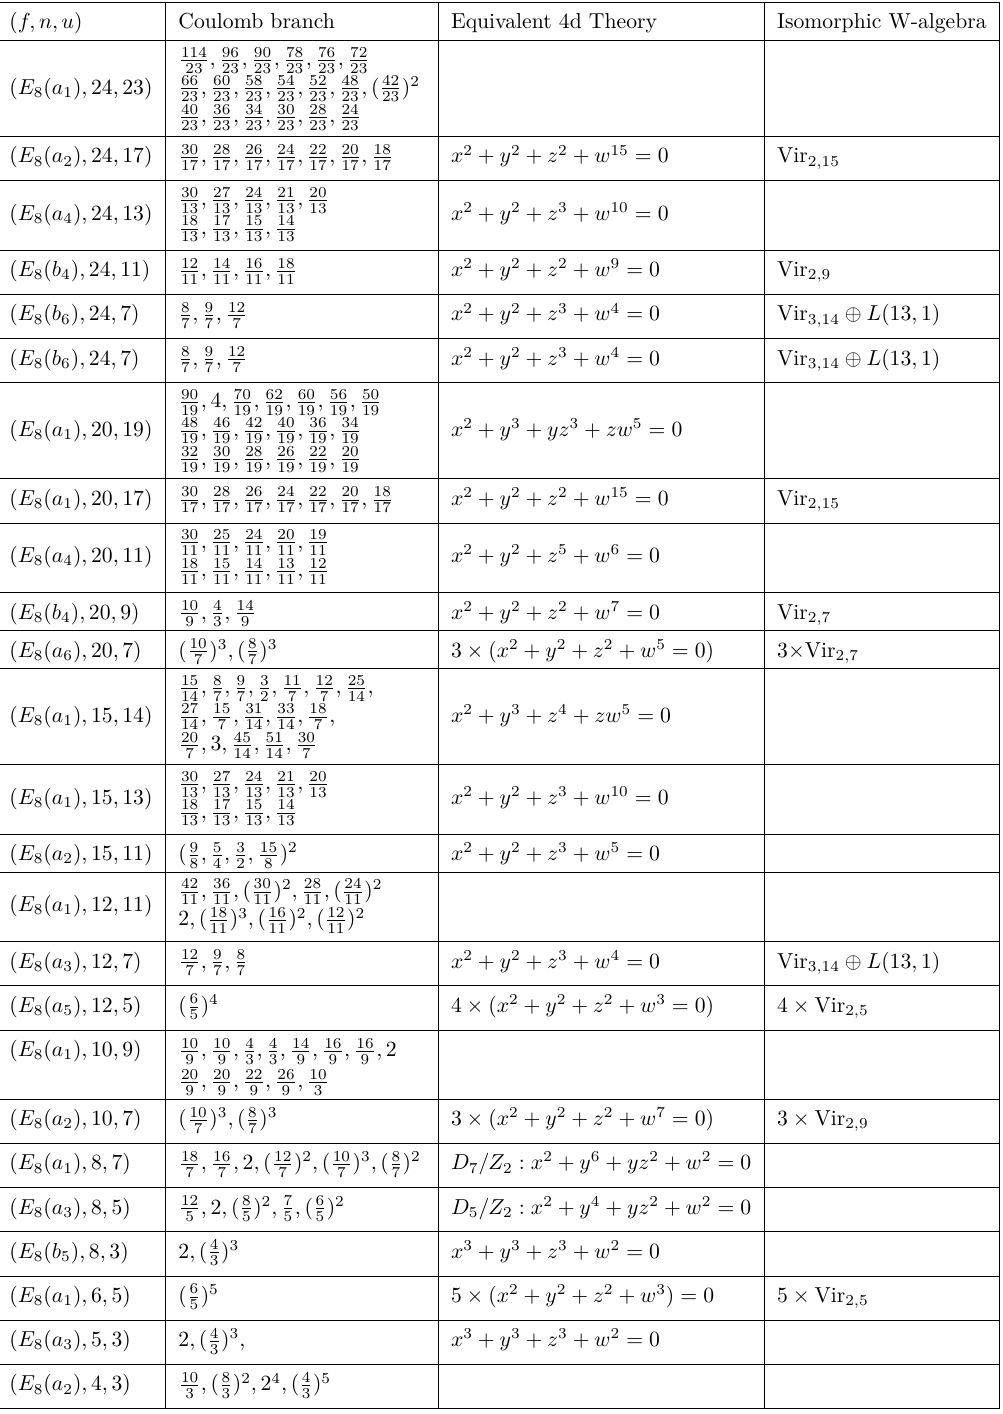
Table 23 . Dimensions of Coulomb branch operators, equivalent 4d descriptions and possible iso- morphic VOAs for 4d theories whose VOA is W − h ∨ + n Again, last two columns (if any) are obtained by matching Coulomb branch operators and cen- tral